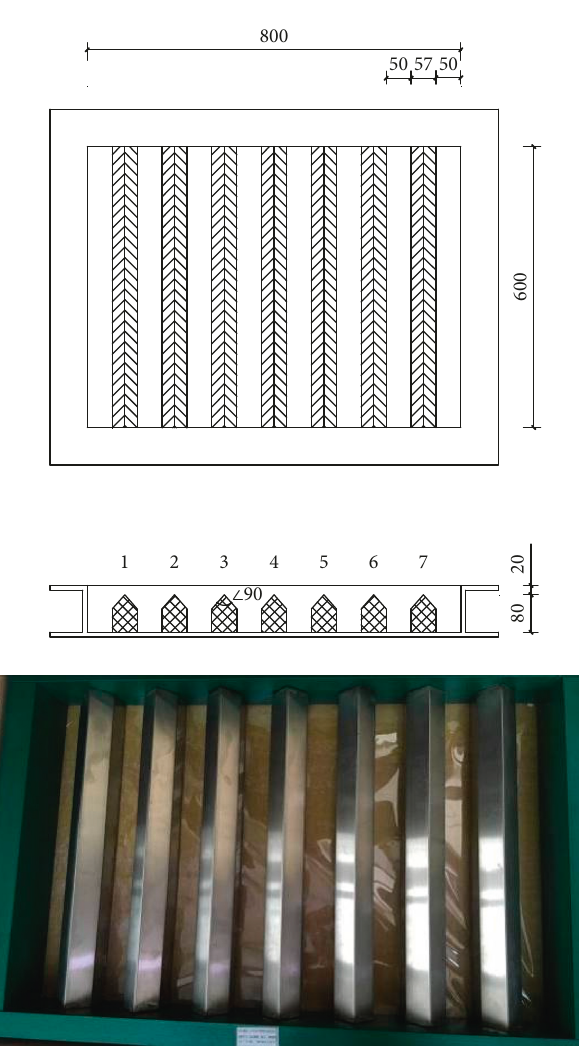
Figure 3: Forming mold of anti-dry-shrinkage cracking perfor- mance test specimens